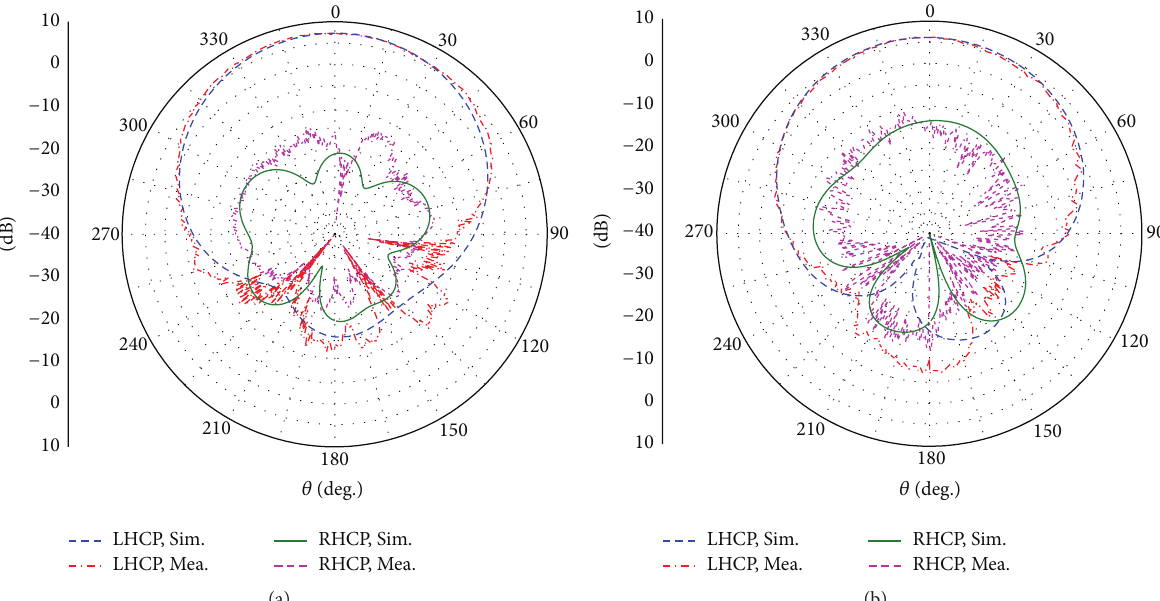
Figure 9: Measured and simulated radiation patterns. (a) 3.6 GHz and (b) 4.4